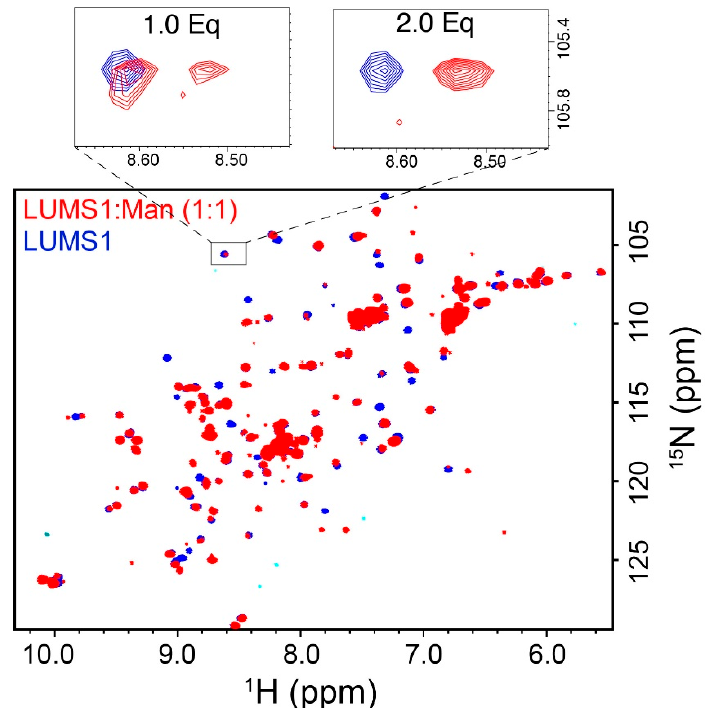
Figure 2. Carbohydrate binding of LUMS1: 15 NHSQC spectra of LUMS1 alone (blue) and in the presence of one equivalent of the α (1-2)mannobiose glycan (red), superimposed. Expansions of a region of spectrum containing single cross-peak in the absence (blue) and presence of one and two equivalents of α (1-2)mannobiose are shown at the top.